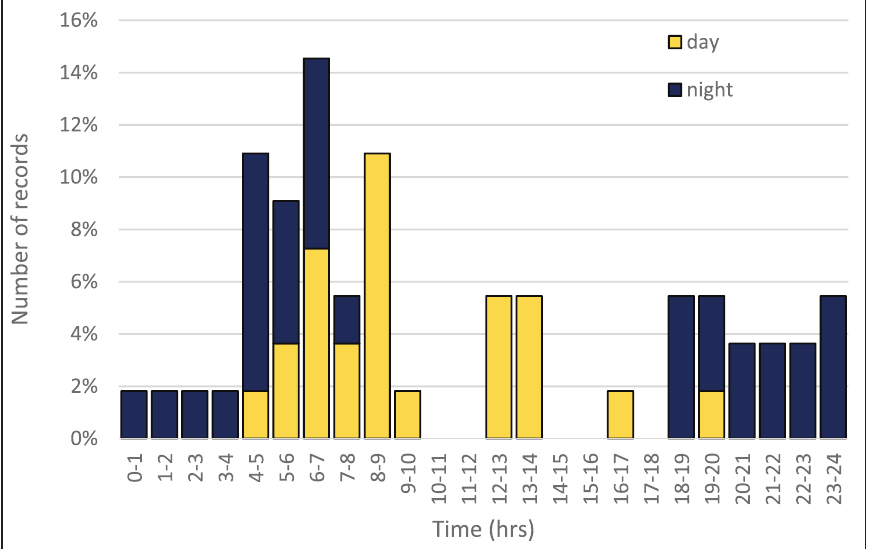
Figure 4. Distribution of the golden jackal ( Canis aureus ) individual’s circadian activity over the study period. Records from the whole monitoring period were pooled and related to the time of the day in which the photographs were